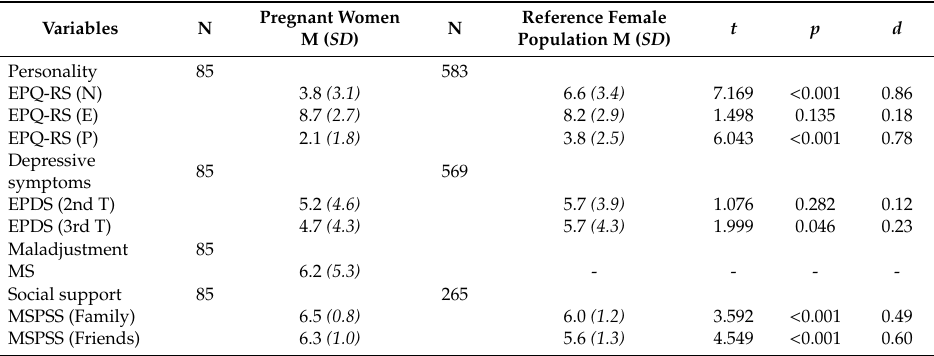
Table 2. Descriptive statistics of study variables and comparison with normative scores.